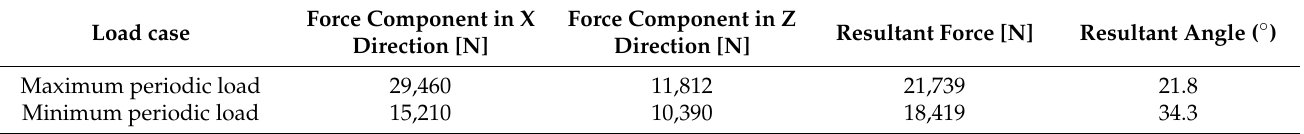
Table 3. Calculation of resultant angle and force from the pressure